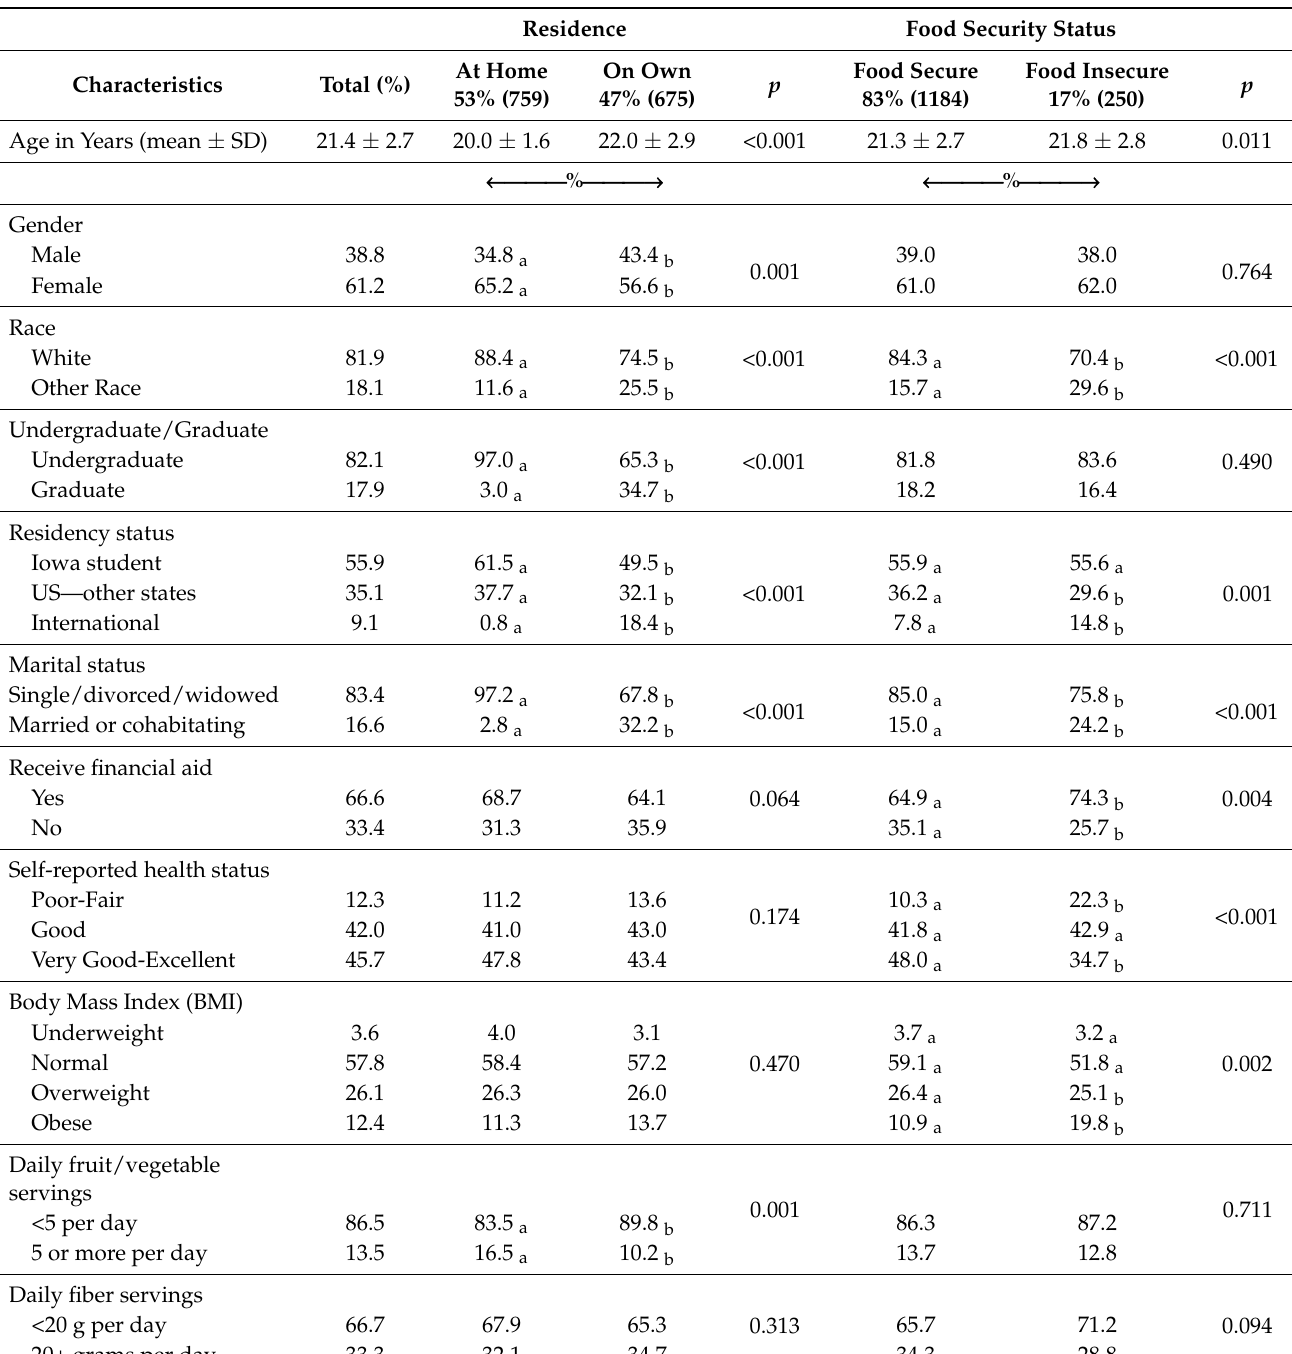
Table 1. Demographic characteristics of Midwestern university students by residence and food security status post-COVID-19 campus shift to online instruction (%; n = 1434).